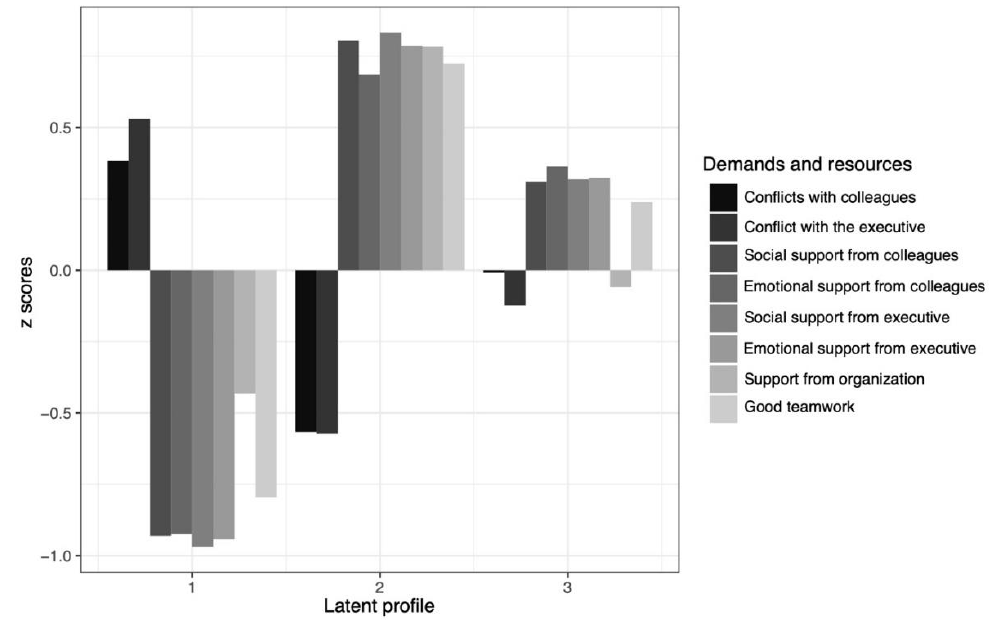
Figure 4. Latent profile solution for demands and resources (z-scores: conflicts with colleagues, conflicts with the executive, social and emotional support from colleagues, social and emotional support from the executive, support from organization, good